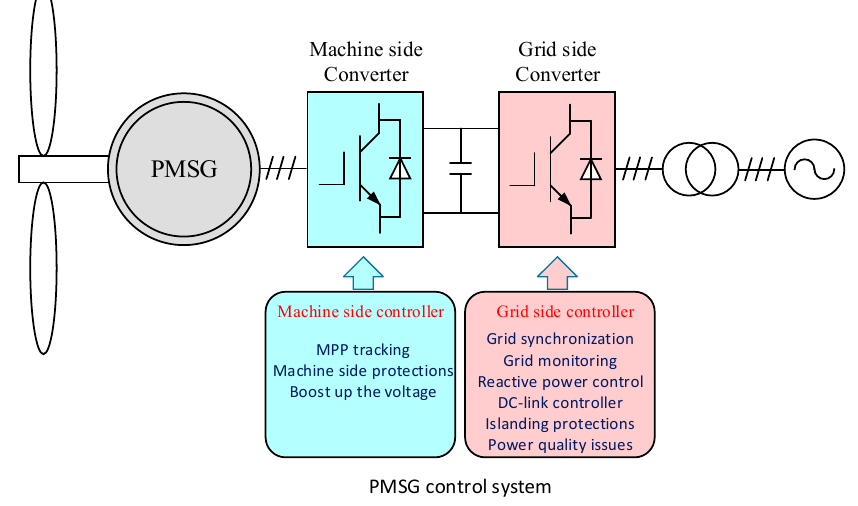
Figure 1. Schematic diagram of direct-drive permanent magnet synchronous generator.